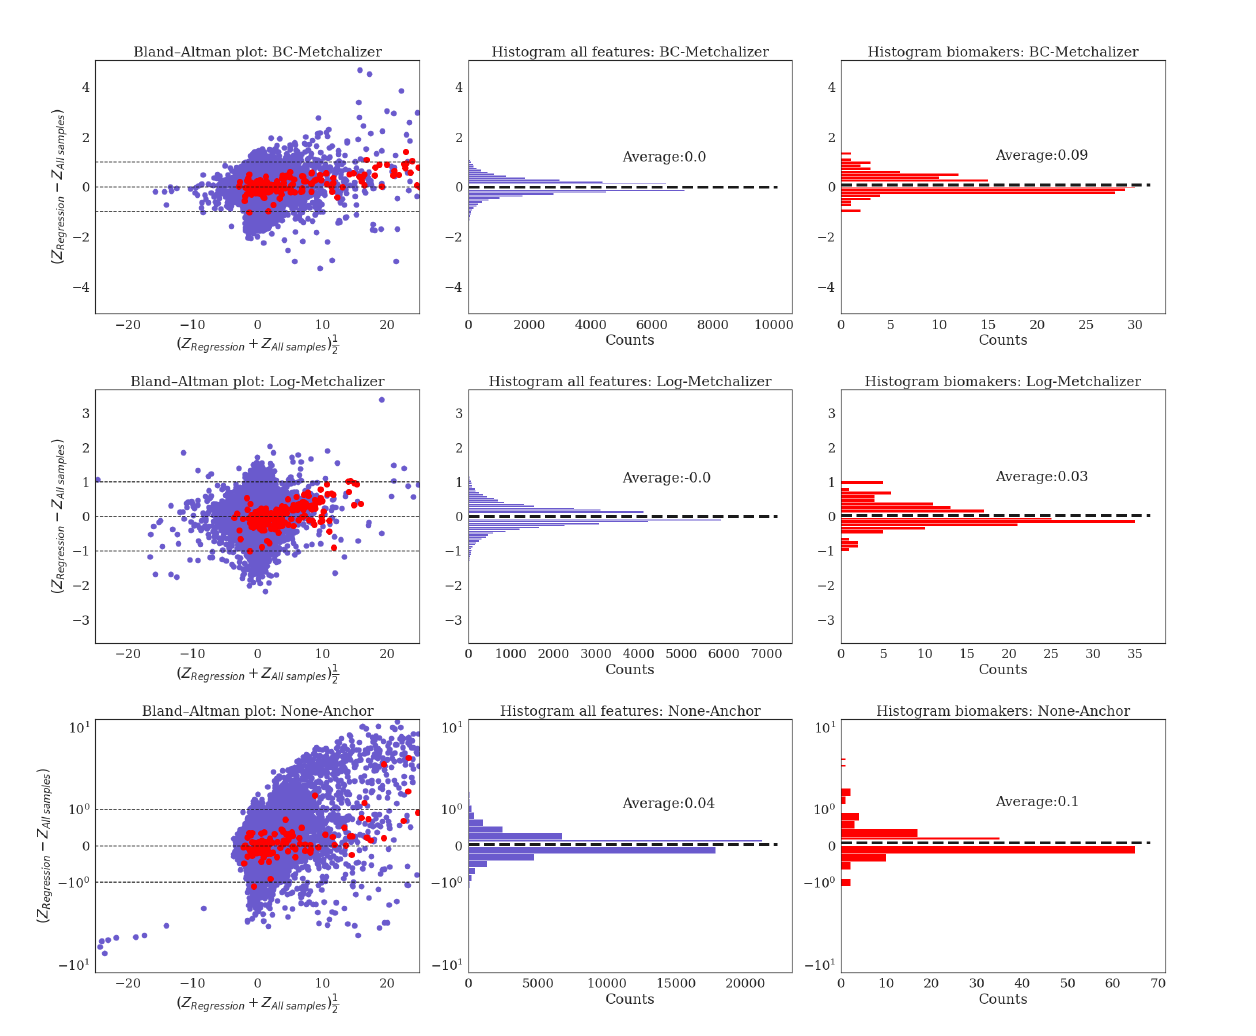
Figure A8. ( Left ) These panels display the Bland- Altman plots where the differences in Z-scores between Regression and All samples are plotted. Blue dots indicate data points originating from a (random) feature and patient whereas the red dots are the IEM biomarkers. ( Middle ) These panels show the distribution of the Z-score differences between the two approaches for all features and patients. ( Right ) The panels show the distribution of the Z-score differences between the two approaches for all IEM